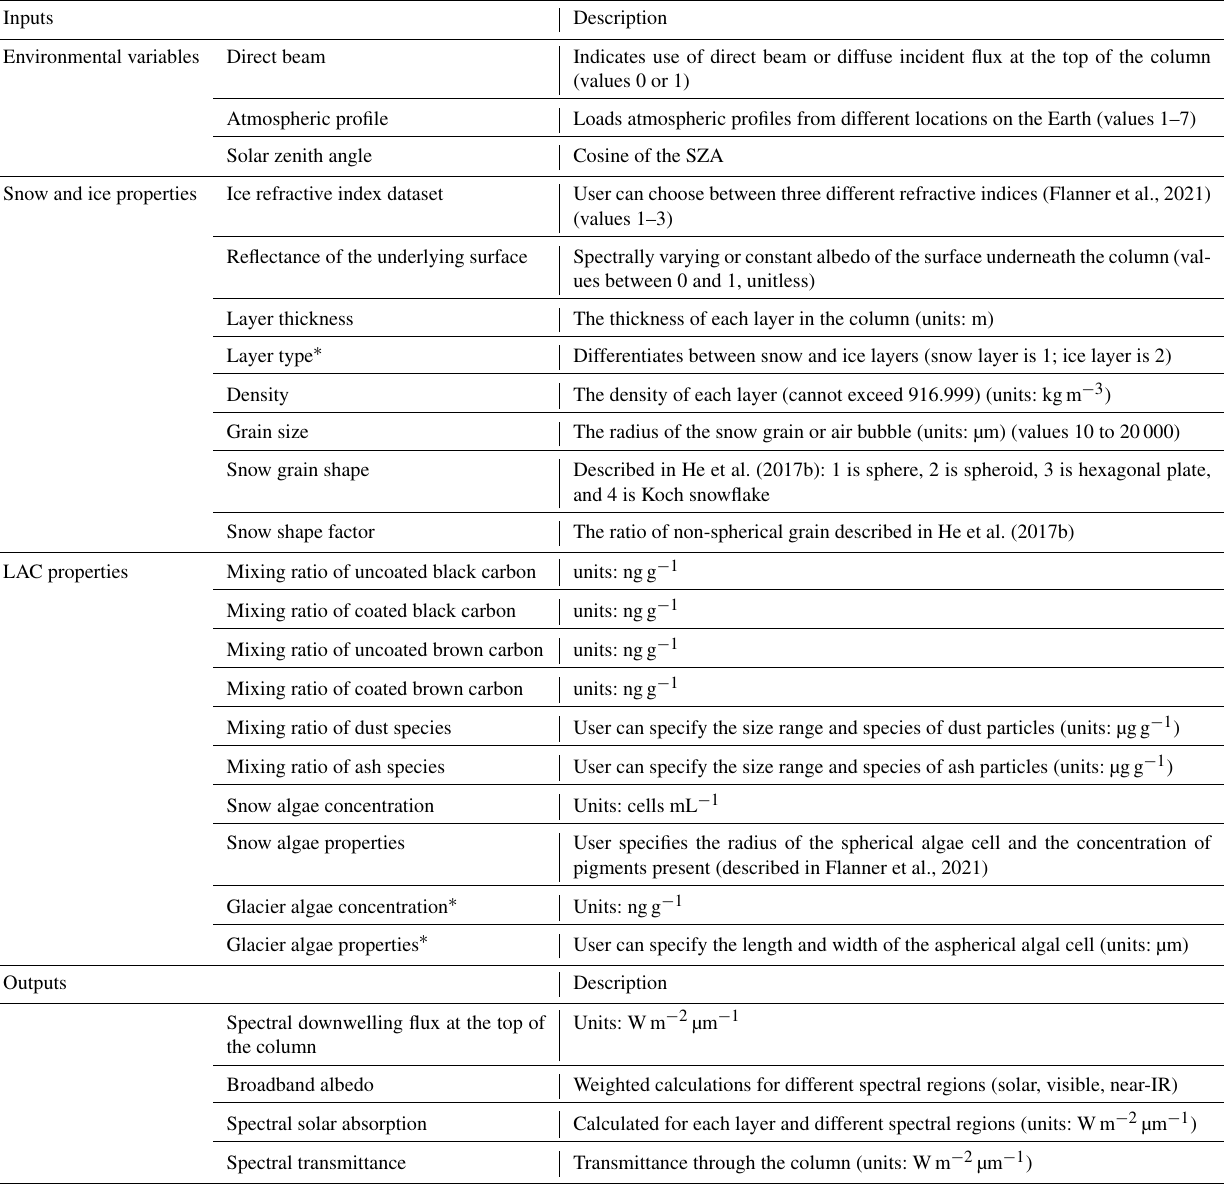
Table 1. Description of each model input and output. The asterisk ( ∗ ) indicates inputs that are unique to SNICAR-ADv4.